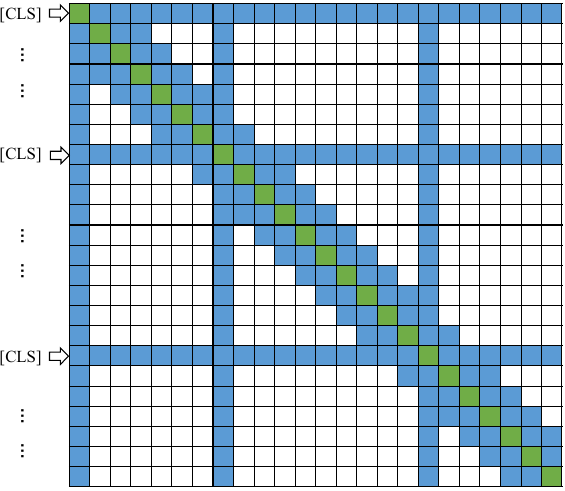
Figure 2. Attention mode of sentence encoder.